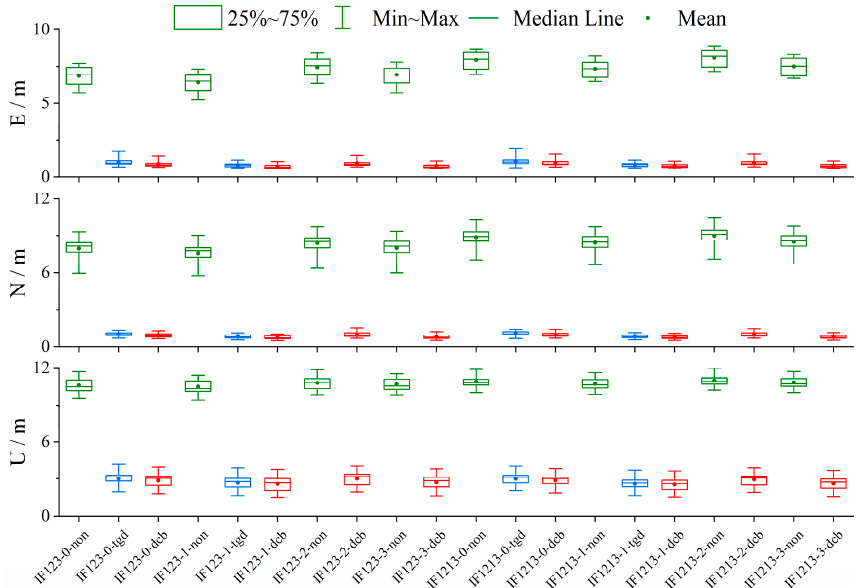
Figure 5. Box plot of IF123 and IF1213 SPP positioning accuracy.